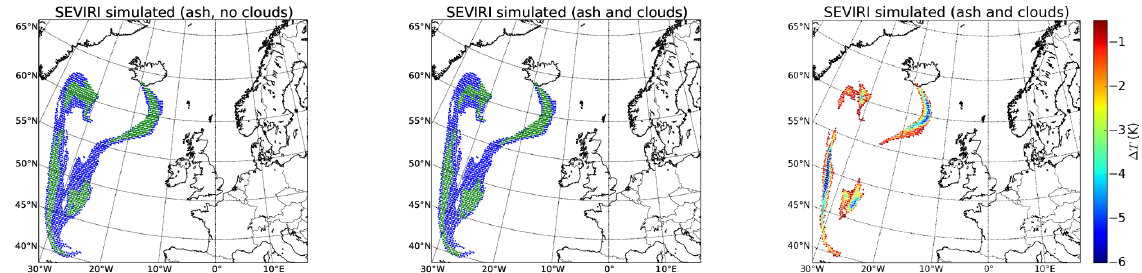
Figure 4. Same as Fig. 3, but for 18:00UTC, 8 May, 2010.